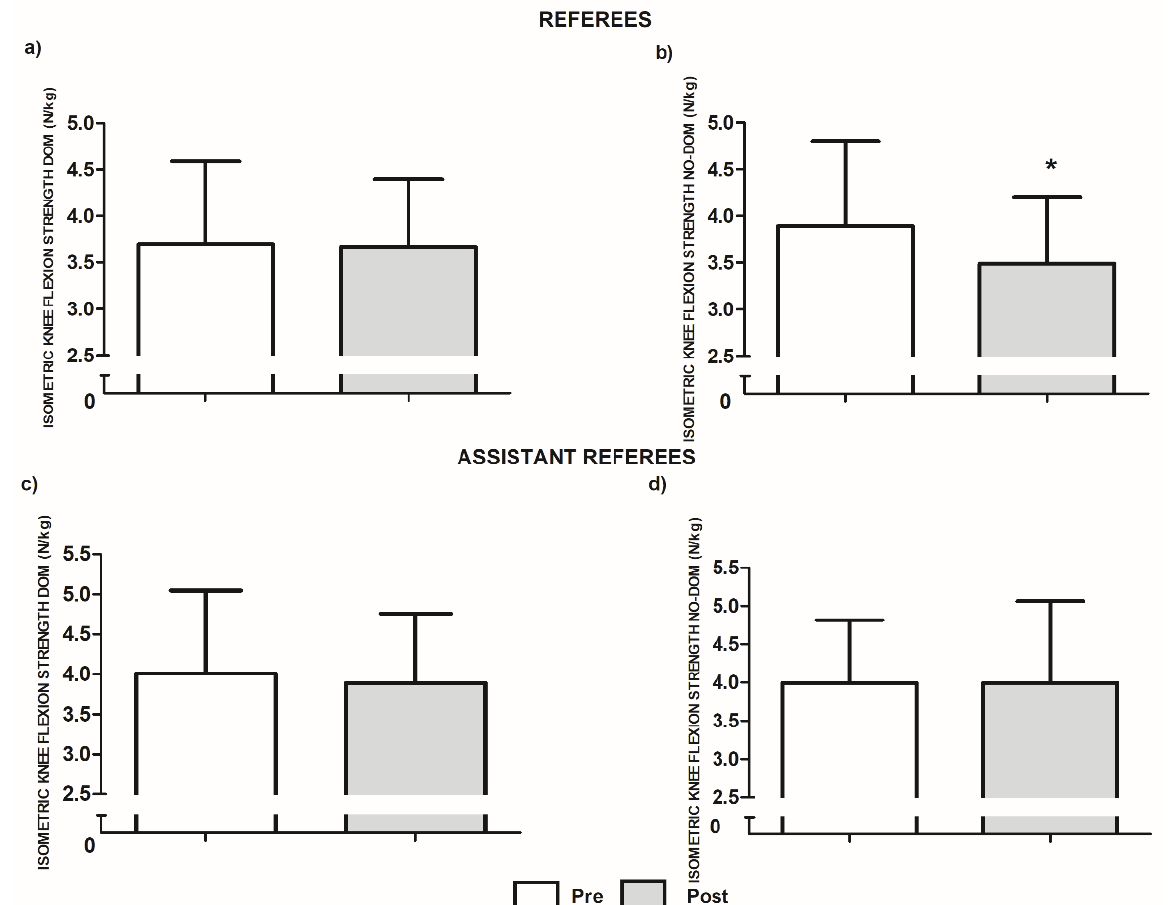
Figure 1. Isometric knee flexion strength values in referees and assistants. N = newton; kg = kilograms; DOM = dominant; NO-DOM = non-dominant. * Significant differences compared to the pre values at p ≤ 0.05.